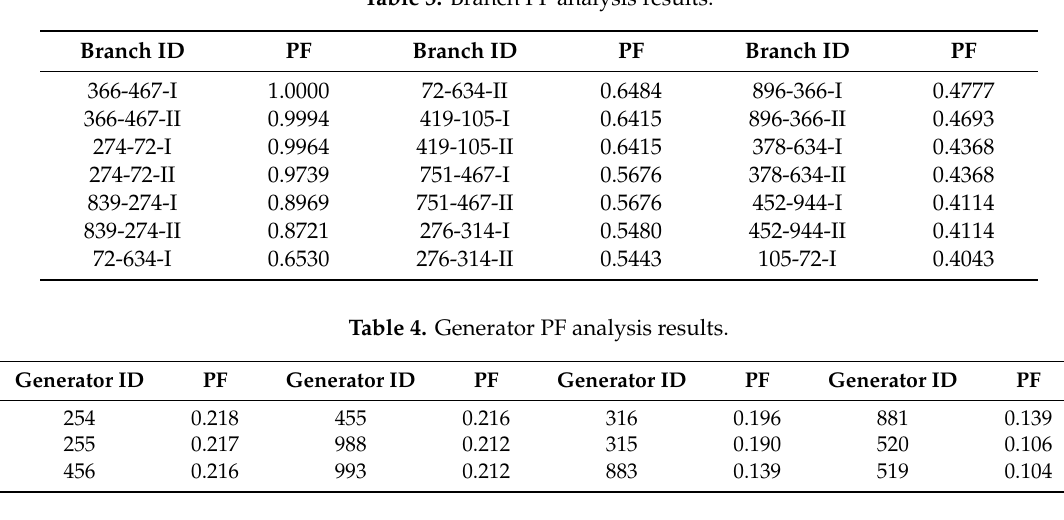
Table 3. Branch PF analysis results.